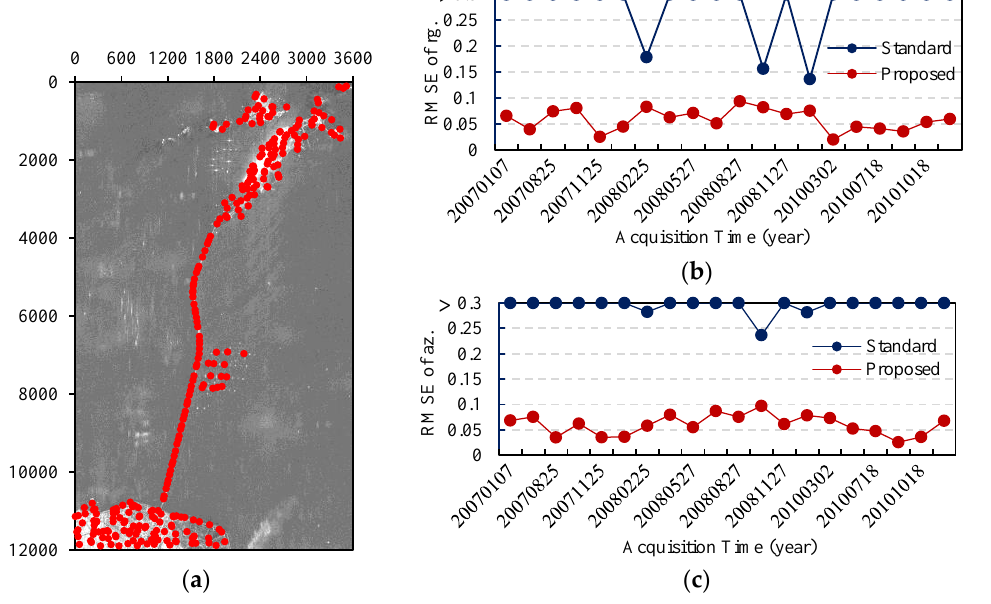
Figure 13. Co-registration results for the Donghai Bridge. ( a ) Distribution of the detected registration points; ( b ) RMSE values of the offset estimates in range; ( c ) RMSE values of the offset estimates in azimuth obtained by both the standard method and the proposed method.